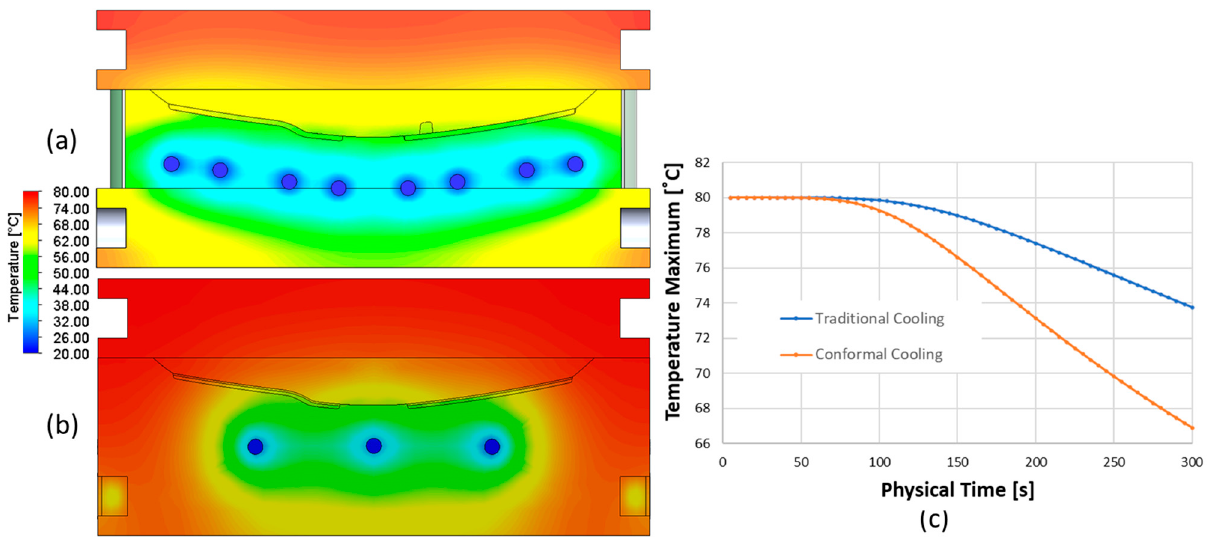
Figure 4. Computational fluid dynamics simulation results. ( a ) Simulation cross-section at center of the mold with conformal cooling channel, ( b ) simulation cross-section at center of the mold with traditional cooling channel, ( c ) simulation results of maximum temperature of molded part versus cooling time.